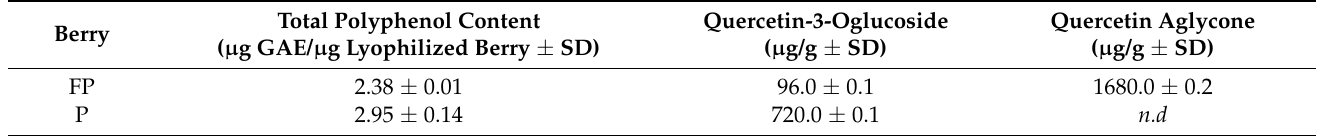
Table 1. Total polyphenol content and quantification of quercetin-3-O-glucoside and quercetin aglycone in lyophilized fermented or not fermented berries. Total Polyphenol Berry